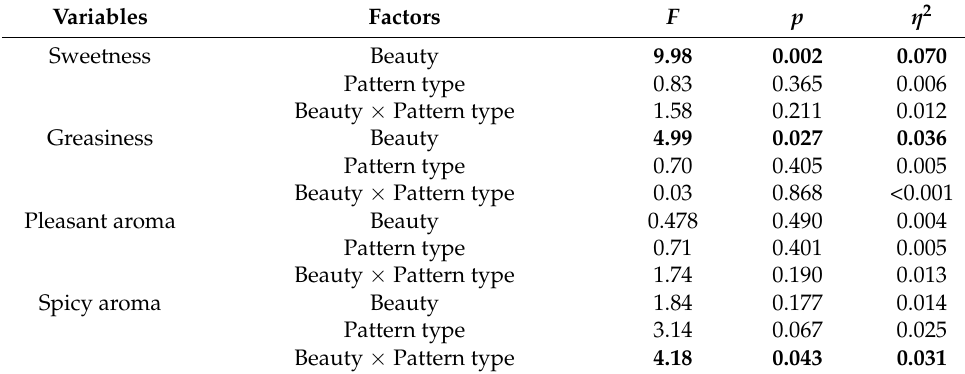
Table 2. ANOVA for element judgment in Experiment 2. ( n =